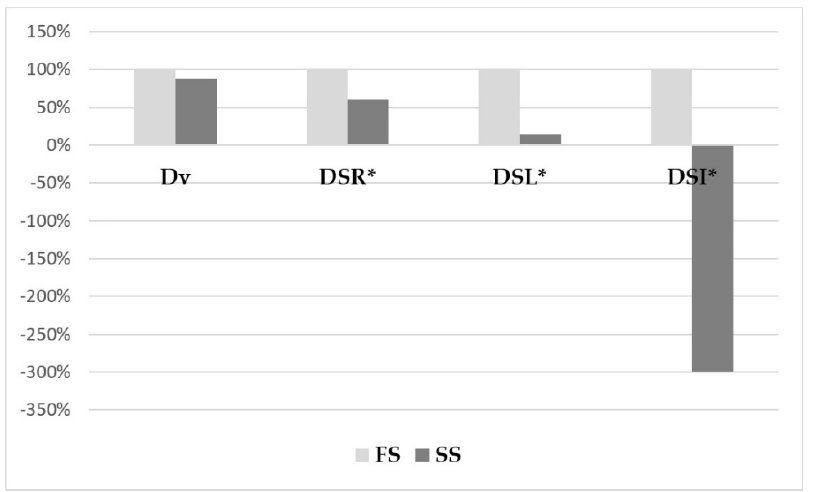
Figure 4. Values of differences in the FS (faster swimmers) and SS (slower swimmers) groups in indices for the 50 and 100 m freestyle races in percentages (the value for the FS group was assumed as 100%). Dv—difference in (mean) velocity, DSR—difference in (mean) stroke rate, DSL—difference in (mean) stroke length, DSI—difference in (mean) stroke index. *—difference between the FS and SS groups at p < 0.05.